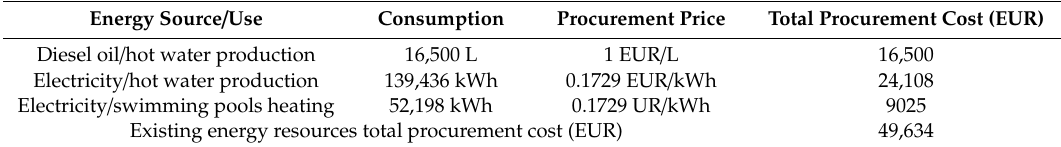
Table 4. Analysis of the energy resources existing procurement cost for hot water production and swimming pools